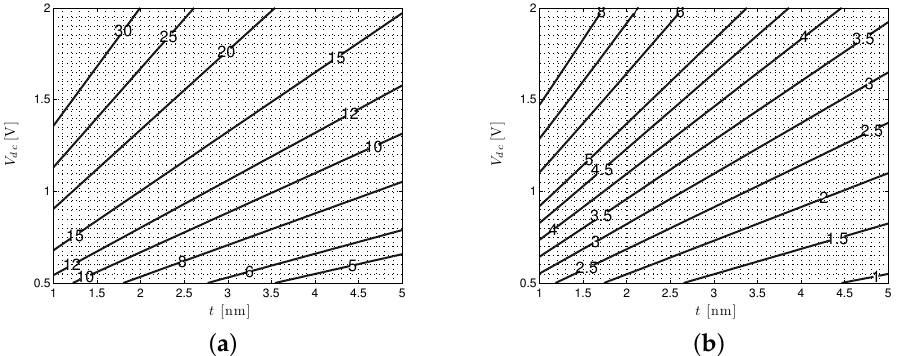
Figure 10. Solid-state nanopore (SSN) ( d = 1.4 nm) I dc and ∆ I as a function of pore bias ( V dc ) and thickness ( t ). ( a ) Contour plot of the I dc (in nA) as a function of nanopore thickness, t , and applied DC bias, V dc ; ( b ) contour plot of the ∆ I (in nA) as a function of nanopore thickness, t , and applied DC bias, V dc